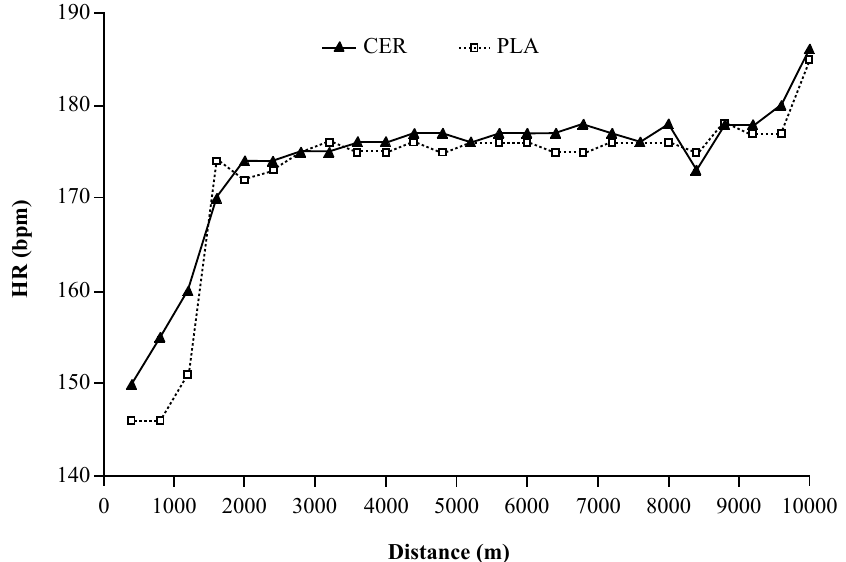
Figure 3. Heart rate (HR) during the performance of 10 km, for condition PLA and CER